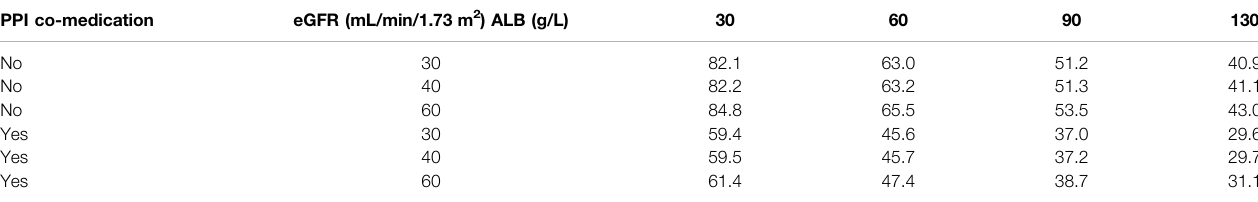
ALB, albumin; PPI, proton pump inhibitor; eGFR, estimated glomerular fi ltration rate. The unit of AUC 0 – 12h was mg · h